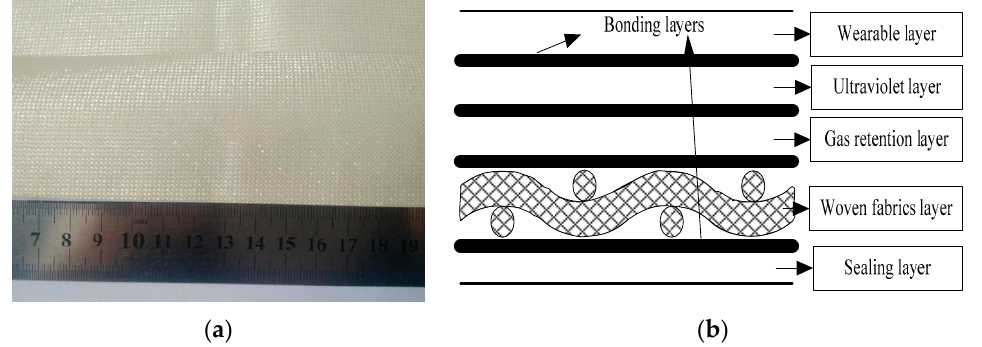
Figure 1. The envelope materials ( a ) macro morphology; ( b ) envelope layout.